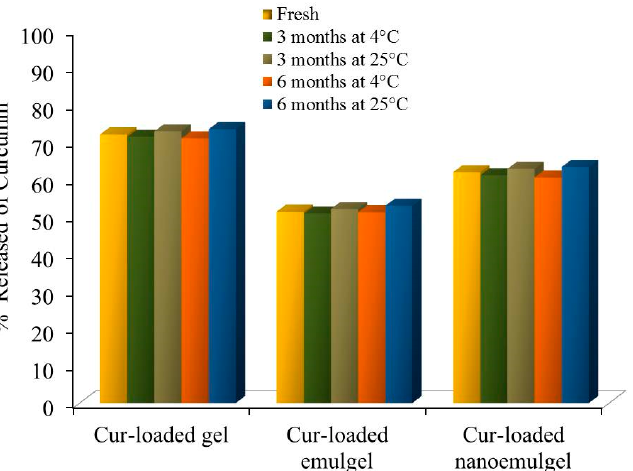
Figure 6. In vitro release study of Cur from different Cur-loaded formulations in phosphate buffer pH 7.4 stored for 3 and 6 months at a relative humidity of 60% and temperature of 4 °C and 25 °C compared with fresh preparations. Results are expressed as the mean ± SD (n = 3).